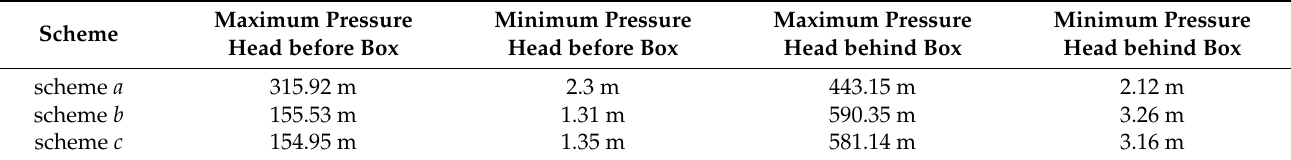
Table 3. Extreme pressure head along pipeline for different schemes.